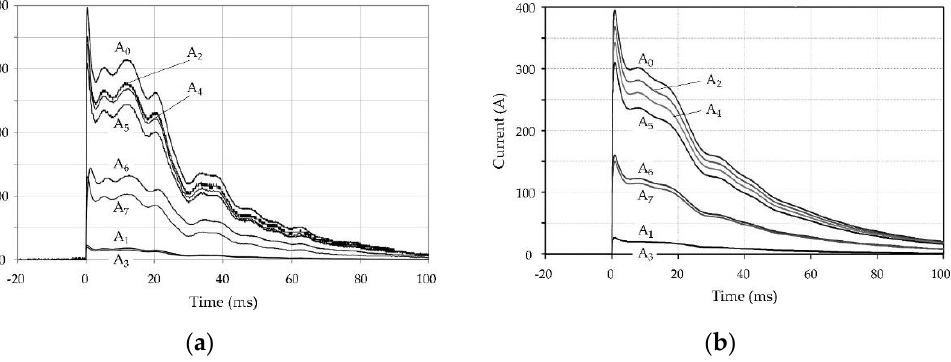
Figure 9. Waveshapes of 30 ms-long impulse current, measured in the tested object: ( a ) measured; ( b ) computed. The denotation of measuring points, A 0 to A 7 , is consistent with Figure 1b.